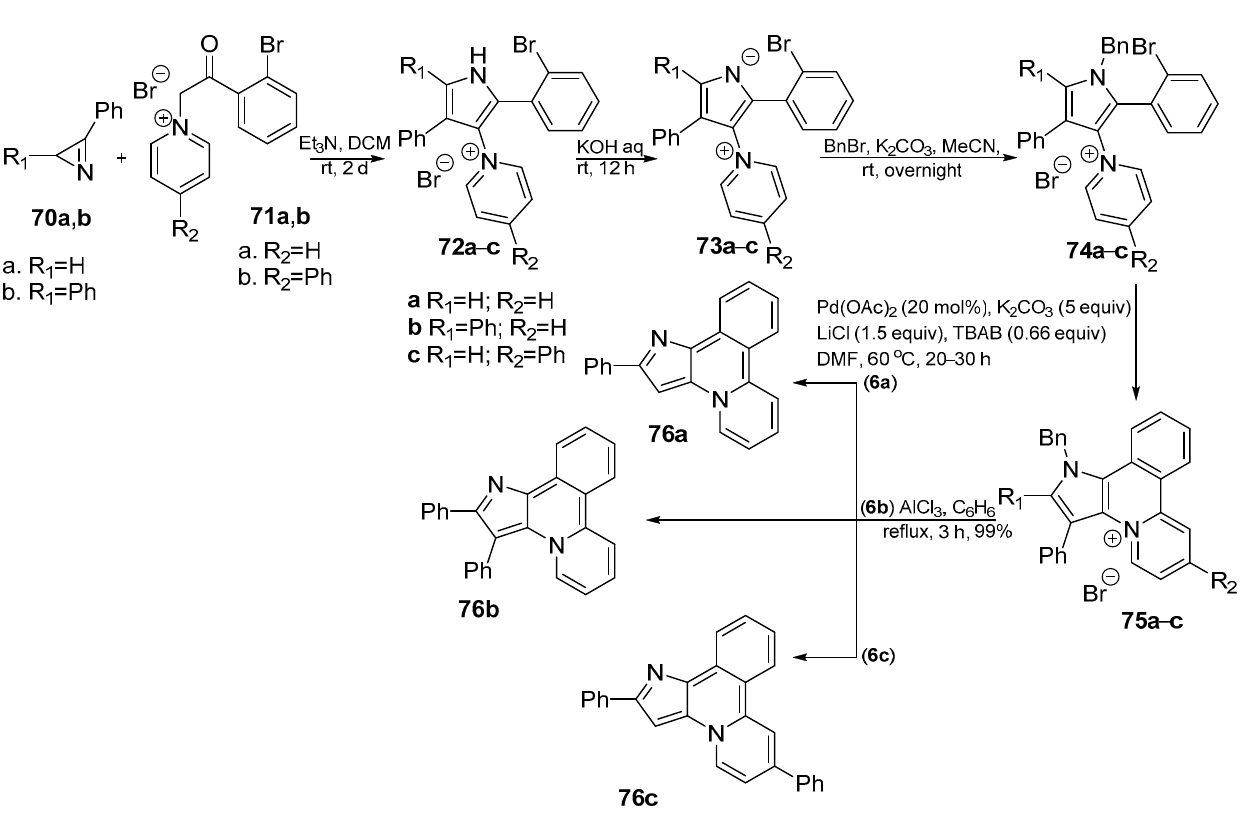
Table 13. Photophysical properties of compounds 76a – c in toluene, acetonitrile, dichloromethane (DCM) and methanol solutions at room temperature, λ ex = 420 nm. Lifetimes ( τ ) were determined at λ max of the emission